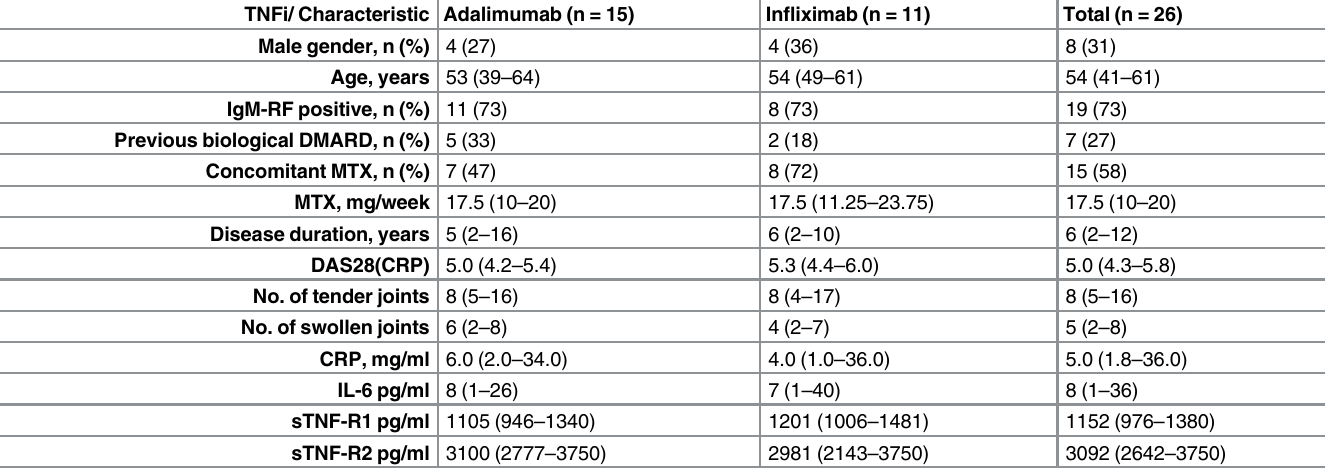
Table 1. Baseline characteristics of the 26 rheumatoid arthritis patients included in the